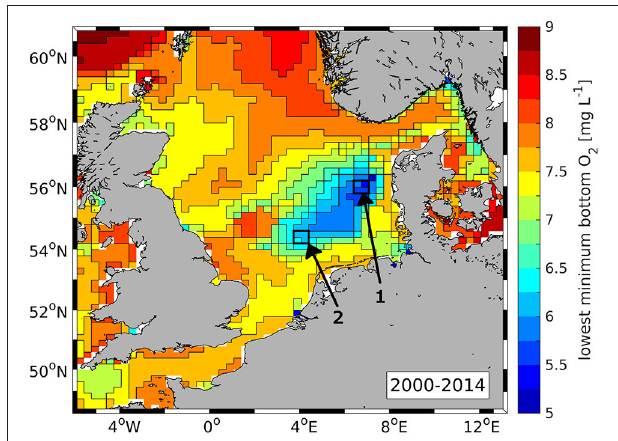
FIGURE 5 | Spatial distribution of lowest simulated bottom O 2 concentration during 2000–2014. Boxes 1 and 2 indicate regions used for the time series analyses in Section